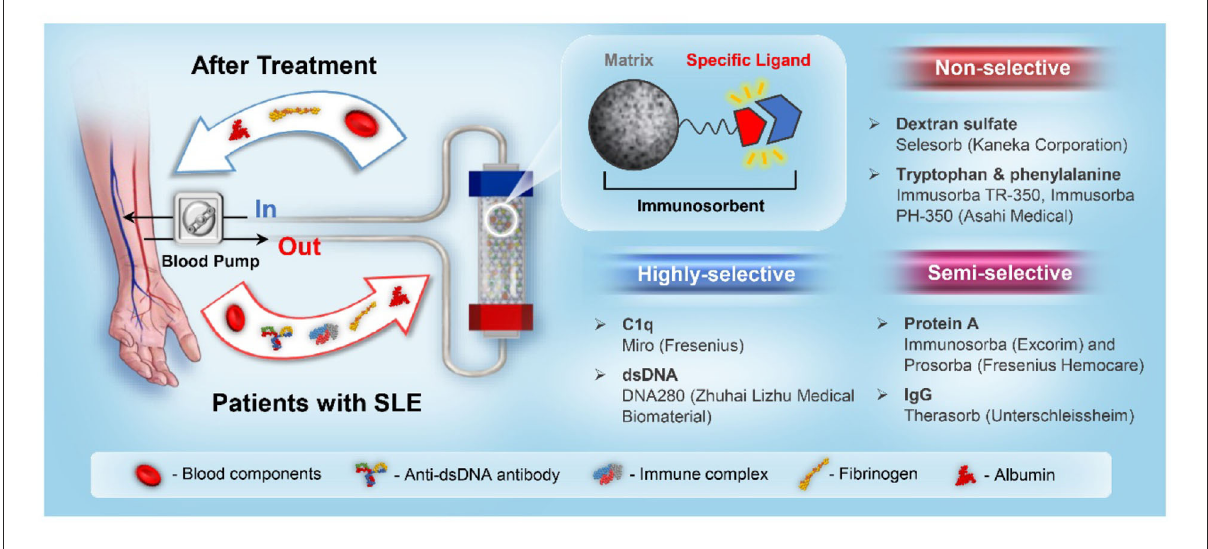
FIGURE1 A schematic illustration of the SLE immunoadsorption system and immunosorbent classification.